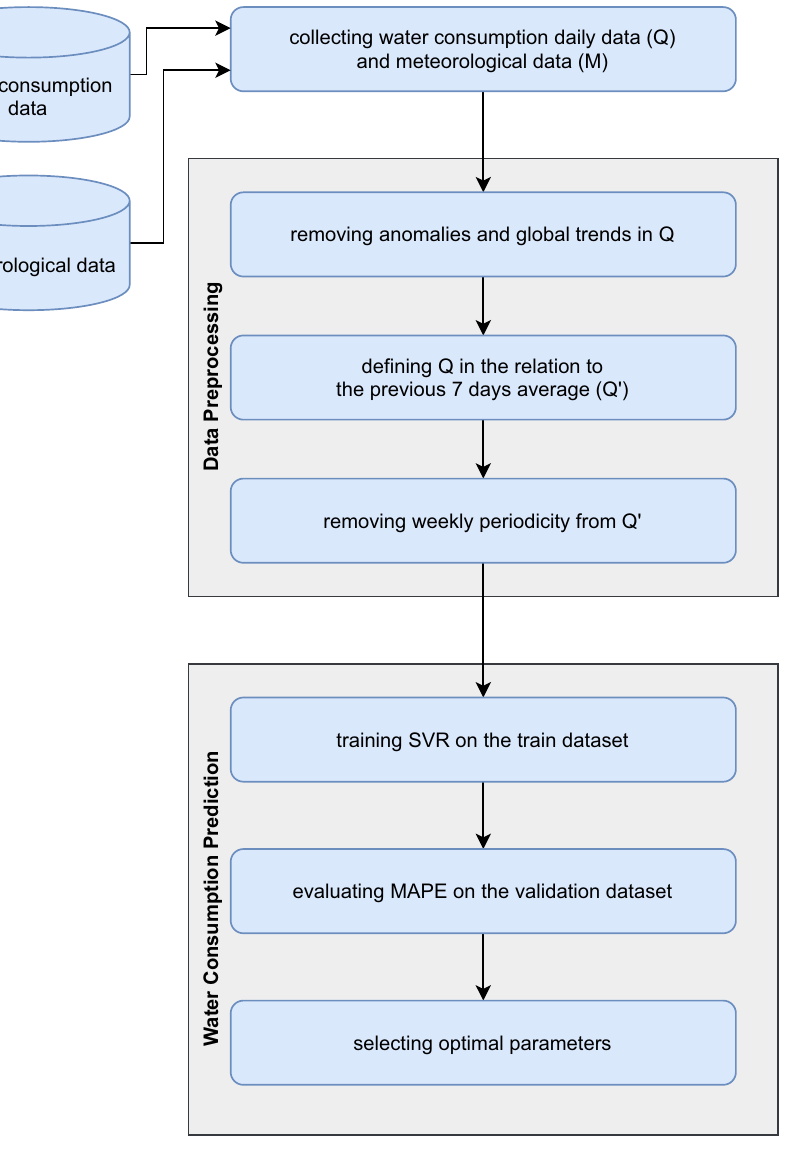
Figure 1. The methodology